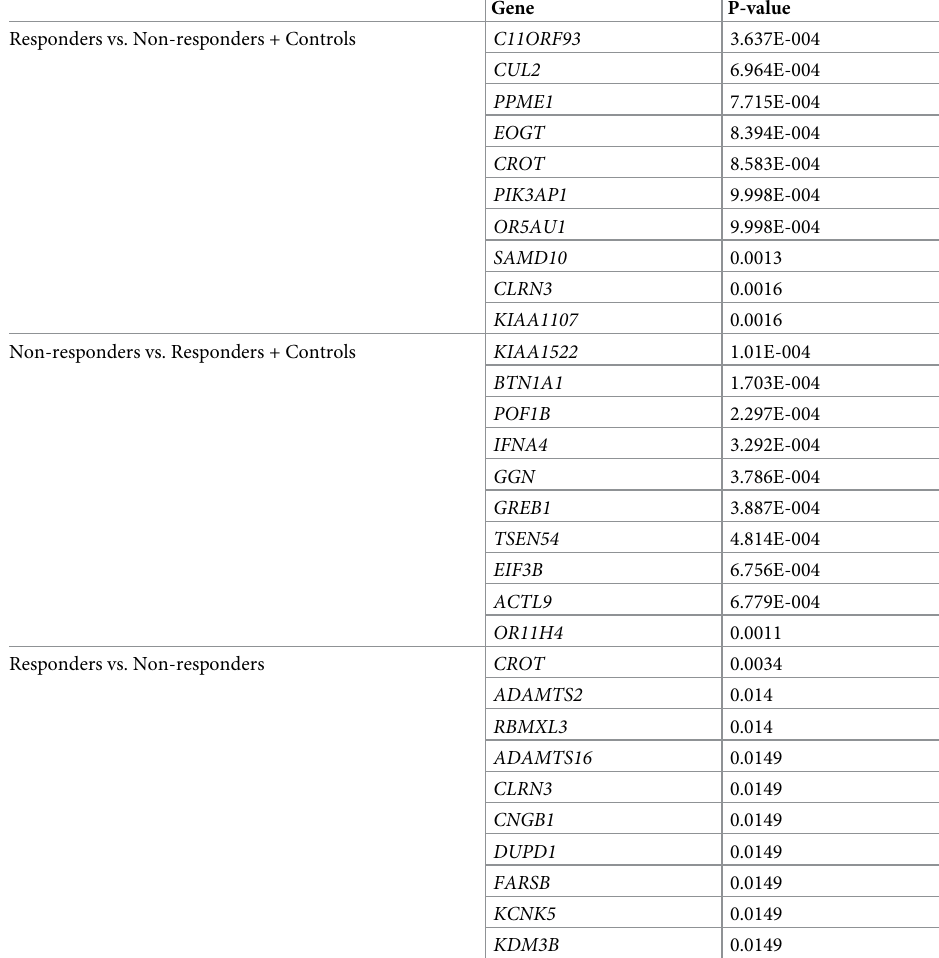
Table 6. Top ten most strongly associated genes in collapsing tests of multiple rare